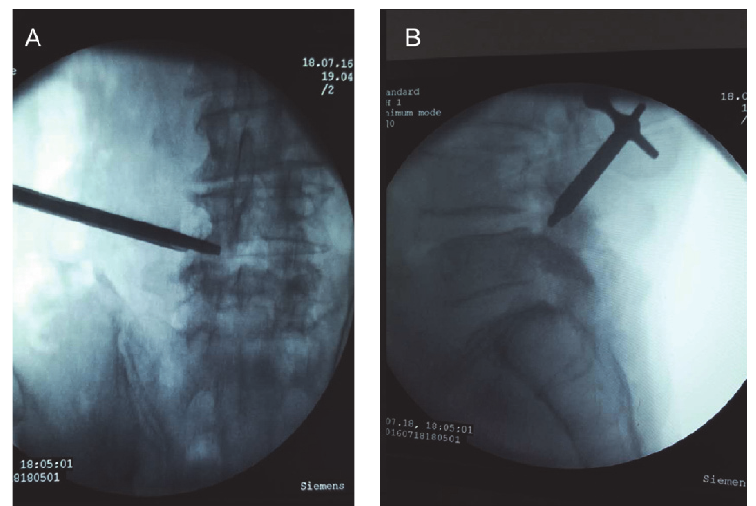
Figure 4: The location pictures after successfully reaching the operation area at L4-5 with a guide bar.